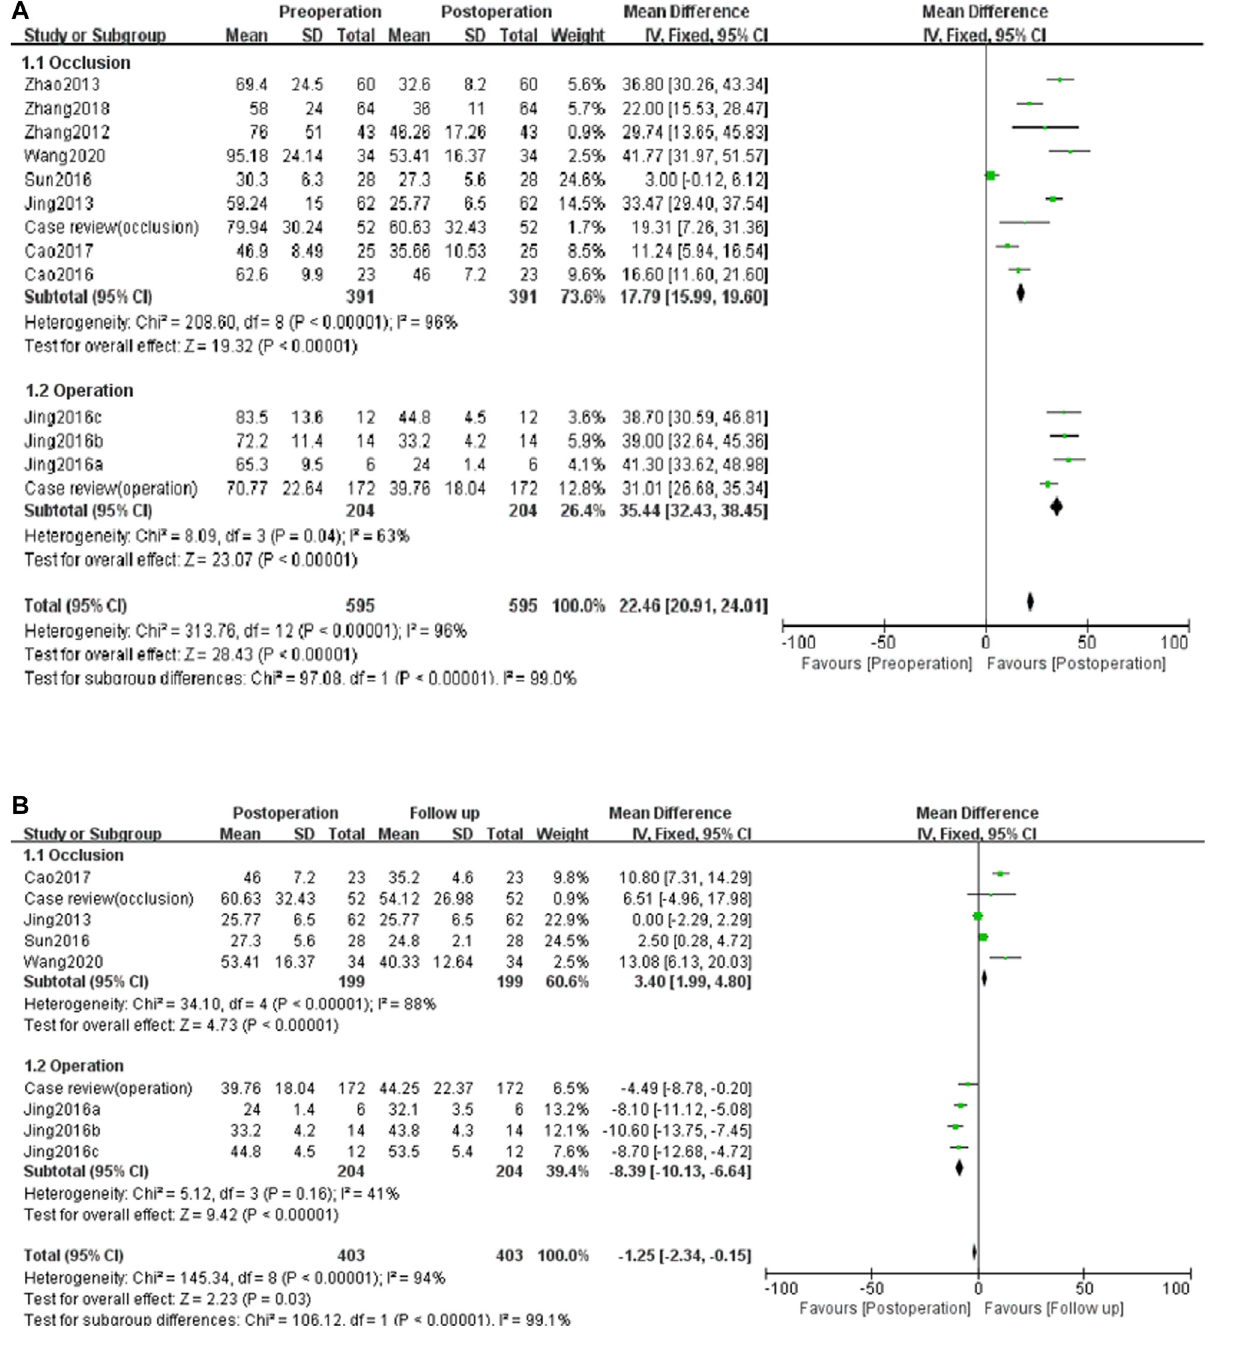
Frontiers in Pharmacology |